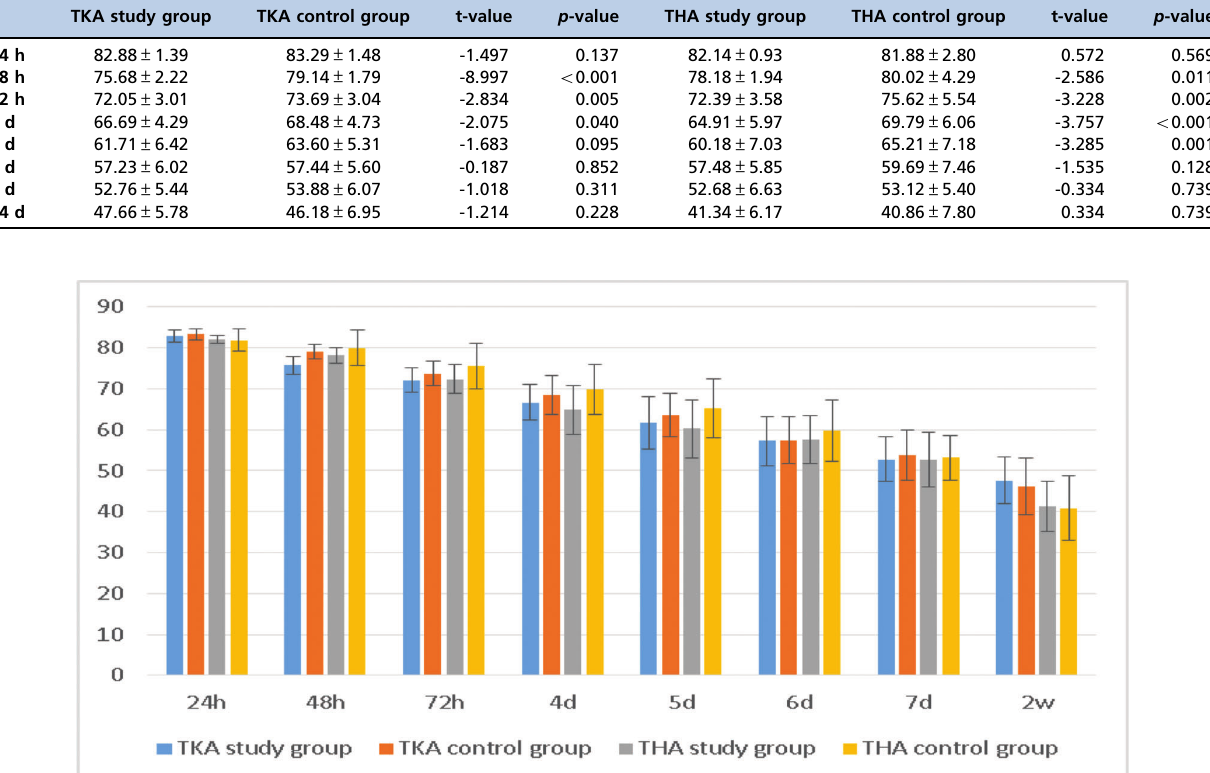
Table 6 - WOMAC scores after the operation.